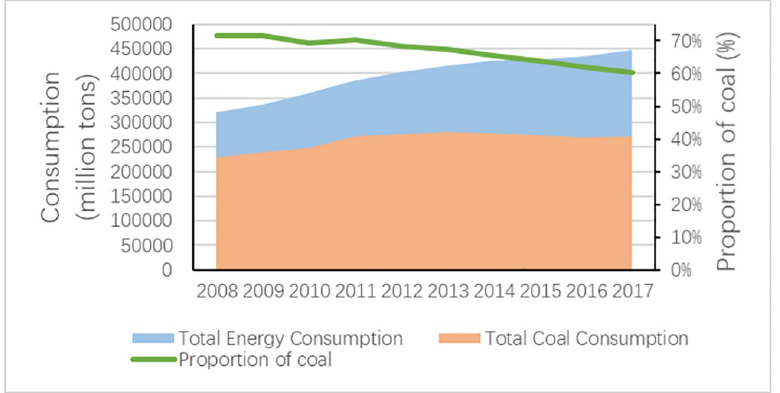
Fig 1. Total coal consumption and its proportion in total energy consumption in China,